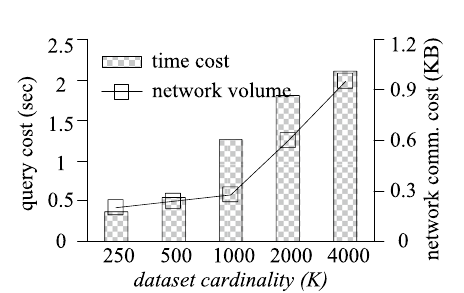
Fig. 10 Effect of num wp